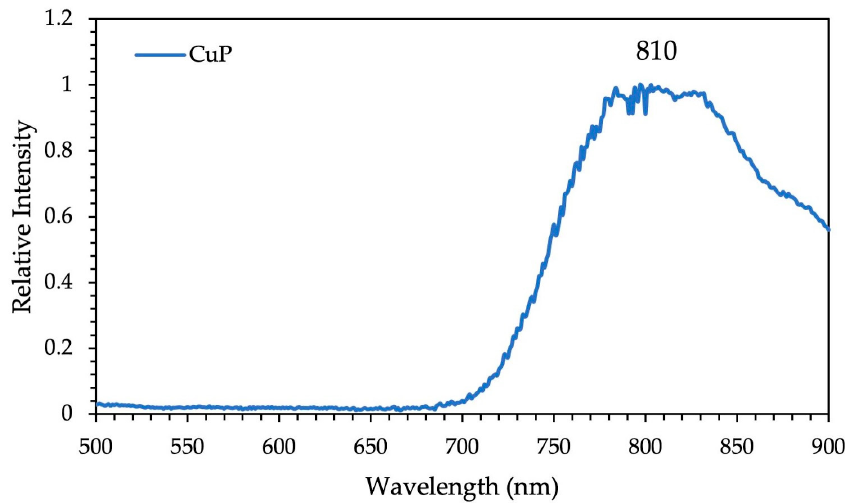
Figure 4. Photoluminescence of CuP in film ( λ exc = 435 nm).